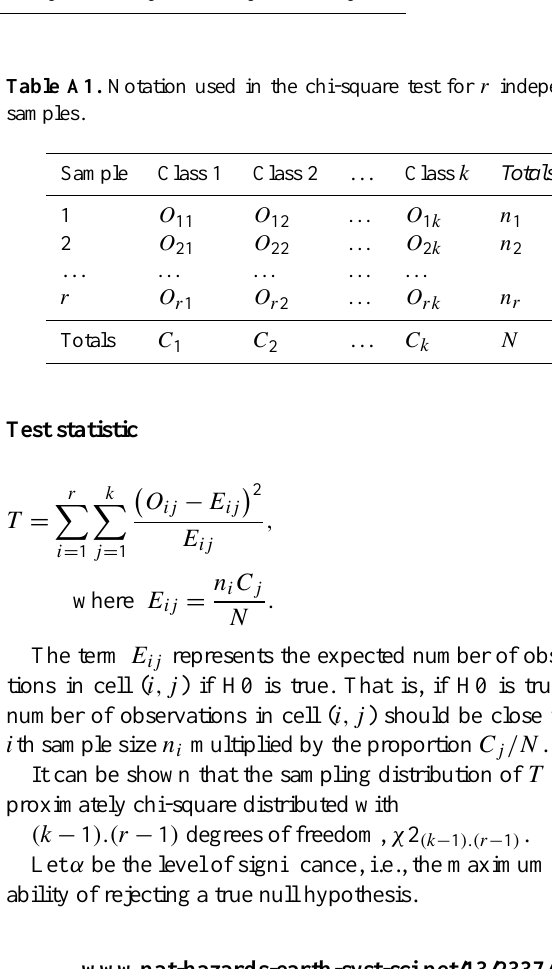
Critical value ( α = 0.05) Conclusion Rej. H0 Critical value ( α = 0.01) Conclusion Rej. H0